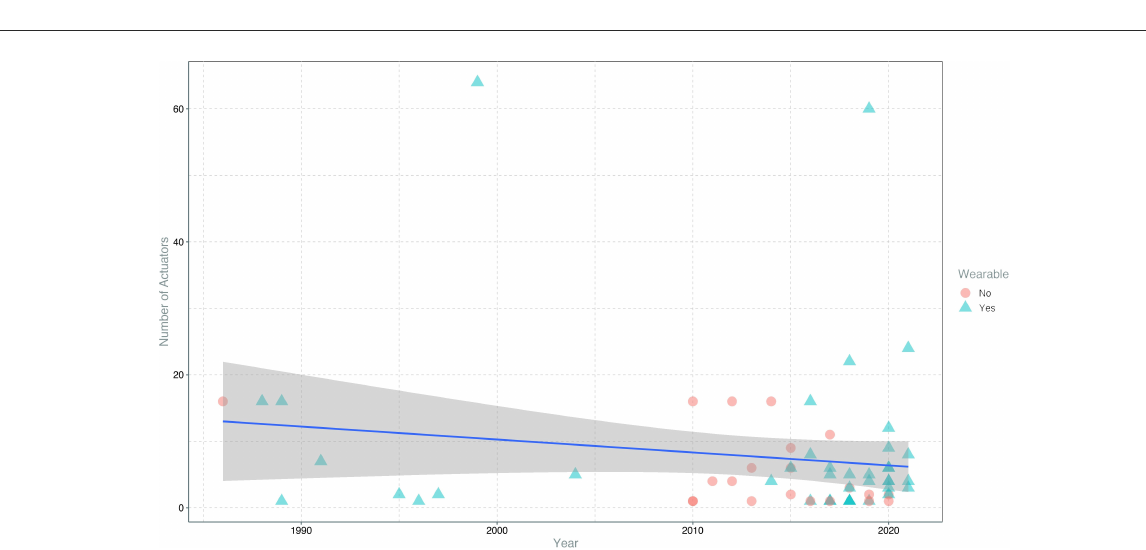
FIGURE3 Distribution of the number of actuators in a device over years; dashed orange line is the mean over years, the blue line is predicted value, and the grey area represents the 95% confidence interval for the estimated number of actuators; a blue triangle indicates a wearable device, and a red circle indicates a fixed device. The prediction model uses a linear regression that was chosen due to the lowest AIC and BIC scores (as described by Burnham and Anderson, 2004) when compared to other models of orders